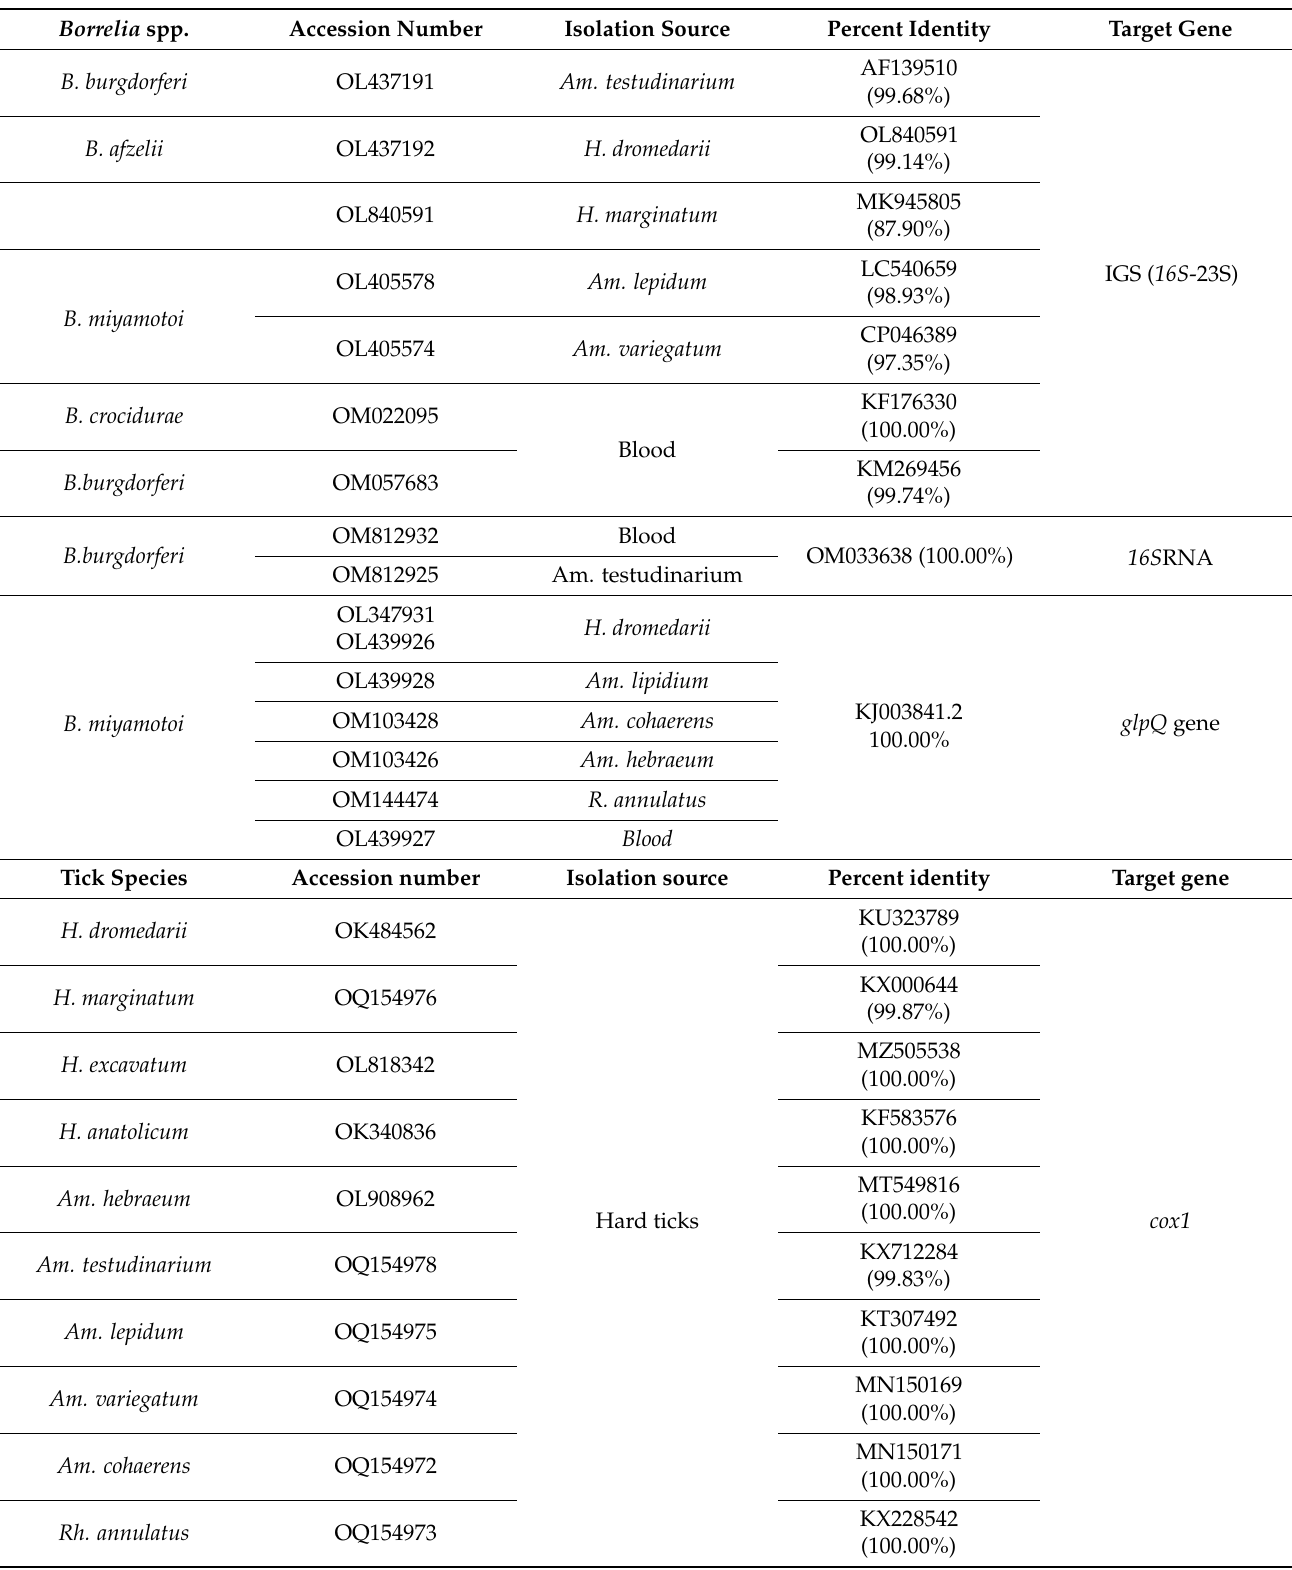
Table 5. Accession numbers of Tick Species and Borrelia spp. in this